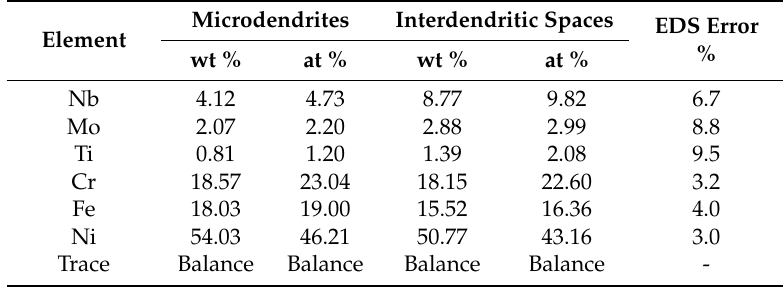
Table 2. Compositions of different phases observed in IN718 powder particles.